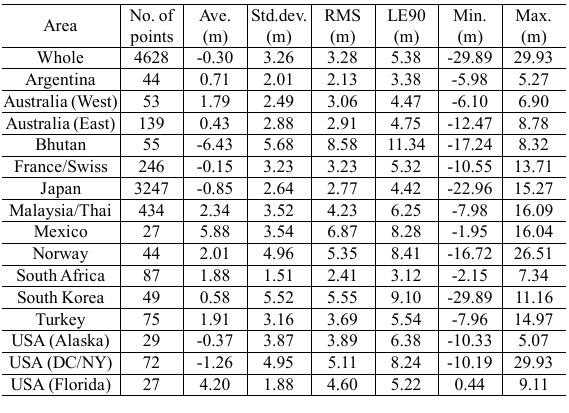
Table 4. Statistics of height difference between DSM tiles and GCPs (DSM-tiles minus GCPs).